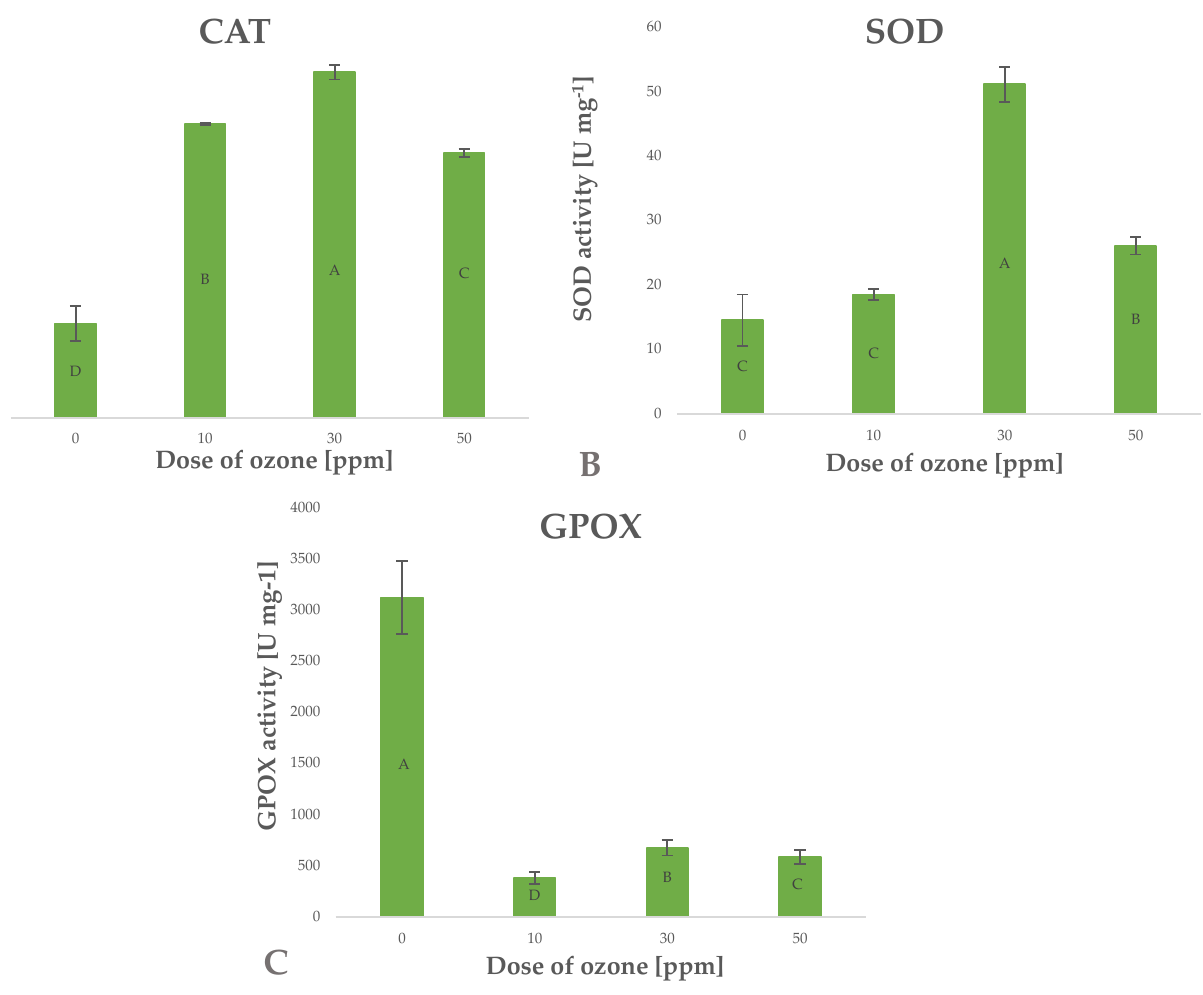
Figure 8. Catalases CAT ( A ), glutathione peroxidases SOD ( B ), guaiacol peroxidase GPOX ( C ) in barley young plants depending on the dose of ozone ( n = 20): differences between the results for the dose of ozone treatment are marked with capital letters; the significance level is defined as p < 0.05.